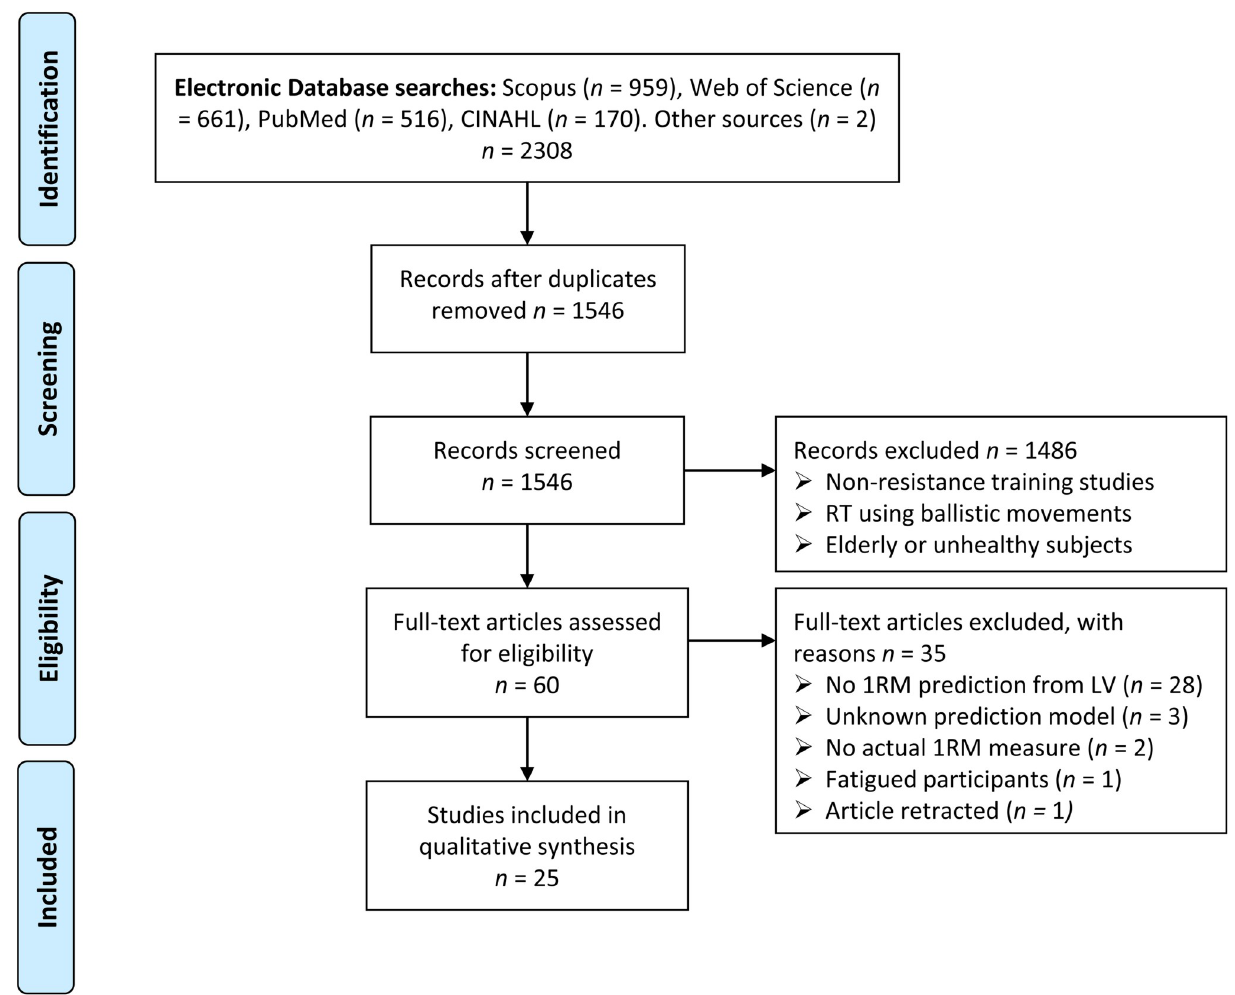
Fig 1. Flow diagram of study selection process. predictions performed using a different number of loads [6,12,18,19,30,31,34,36,39–43]. Of the studies examining the use of a different number of loads, four [6,30,34,36] also assessed whether this influenced the reliability of 1RM predictions. Upper body exercises were exam- ined 19 times, whereas lower body exercises were examined 11 times. Fifteen studies examined free-weight exercises, 12 exercised on the Smith machine and three studies examined different machine-based exercises and report valid 1RM predictions in bilateral and unilateral leg exten- sion [29], cable lat pull-down and cable seated row [42] and the pin-loaded chest press and leg press [13]. A further two studies have also directly compared 1RM prediction validity and reli- ability between Smith machine and free-weight variations of the same movement pattern, spe- cifically for the bench press [17] and bent-over row [15]. Seventeen (68%) studies developed LVRs using MCV exclusively [6,12,13,18,19,28–31,33,34,37,39–43] and two (8%) solely used MPV [17,35]. Additionally, five studies (20%) have directly compared 1RM predictions per- formed using different velocity metrics; namely the MCV, MPV and PCV [9,15,32,38,44].